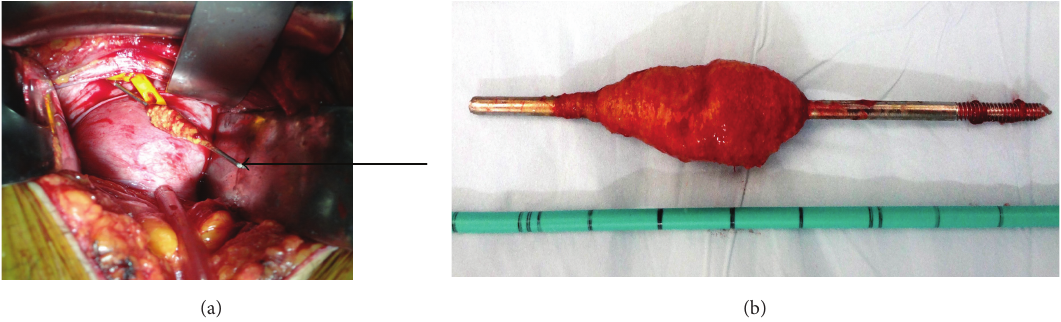
Figure 4: (a) Intraoperative photograph of the K-wire in the bladder. (b) The K-wire after removal from the